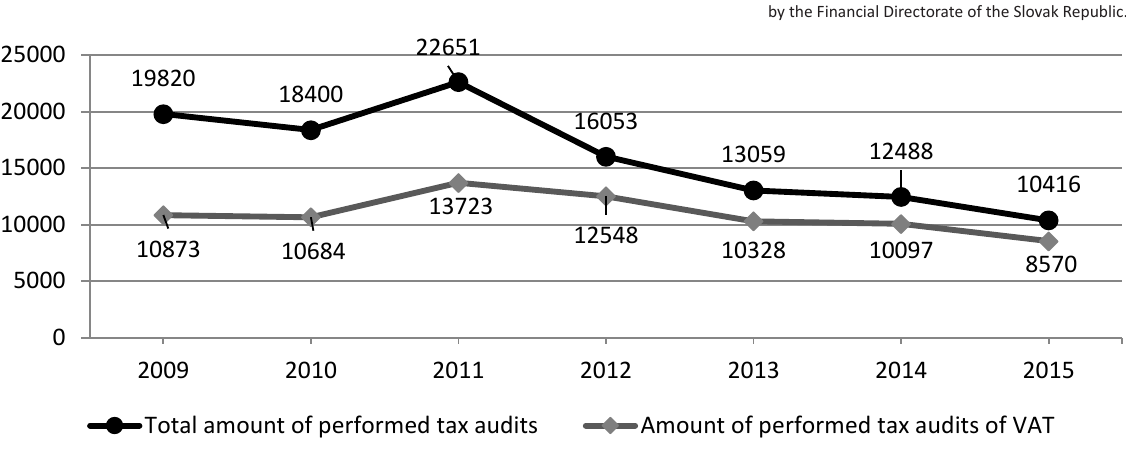
Figure 1. Number of tax audits performed in the period